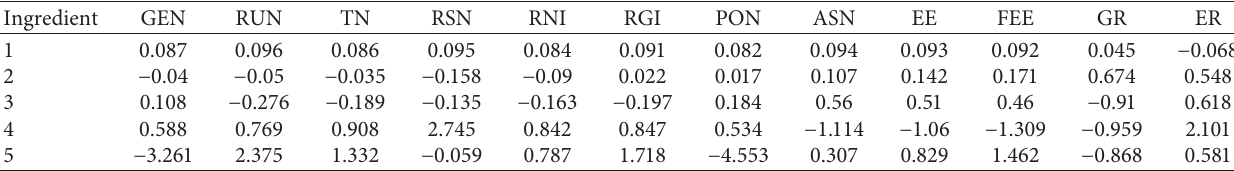
Table 2: Composition score coefficient matrix.